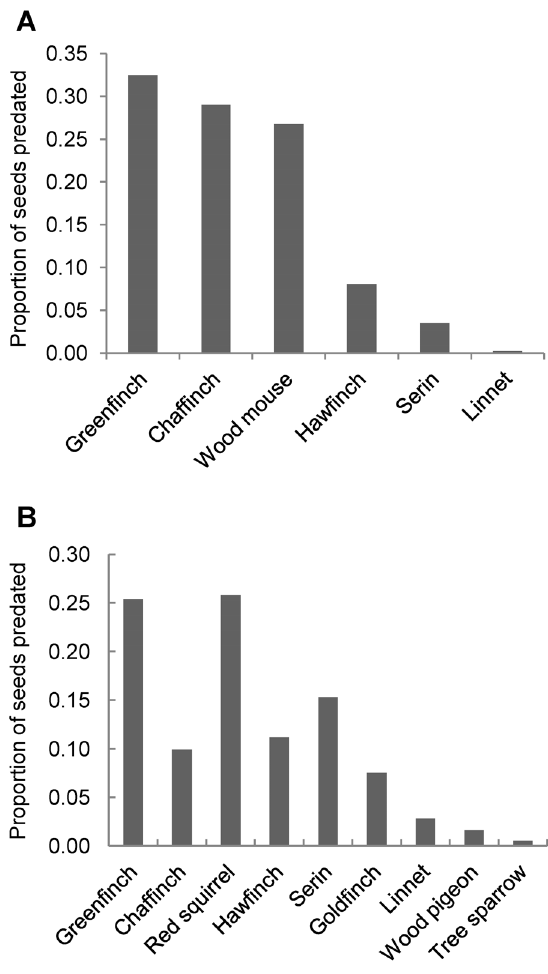
Figure 3. Proportion of samaras consumed by each animal species ( n . 5 contacts). a) on the ground (open microhabitat); b) in the tree. Greenfinch= Carduelis chloris ; Chaffinch= Fringilla coelebs ; Wood mice= Apodemus sylvaticus ; Goldfinch= Carduelis carduelis ; Ser- in= Serinus serinus ; Linnet= Carduelis cannabina ; Red squirrel= Sciurus vulgaris ; Wood pigeon= Columba palumbus ; Tree sparrow= Passer montanus .